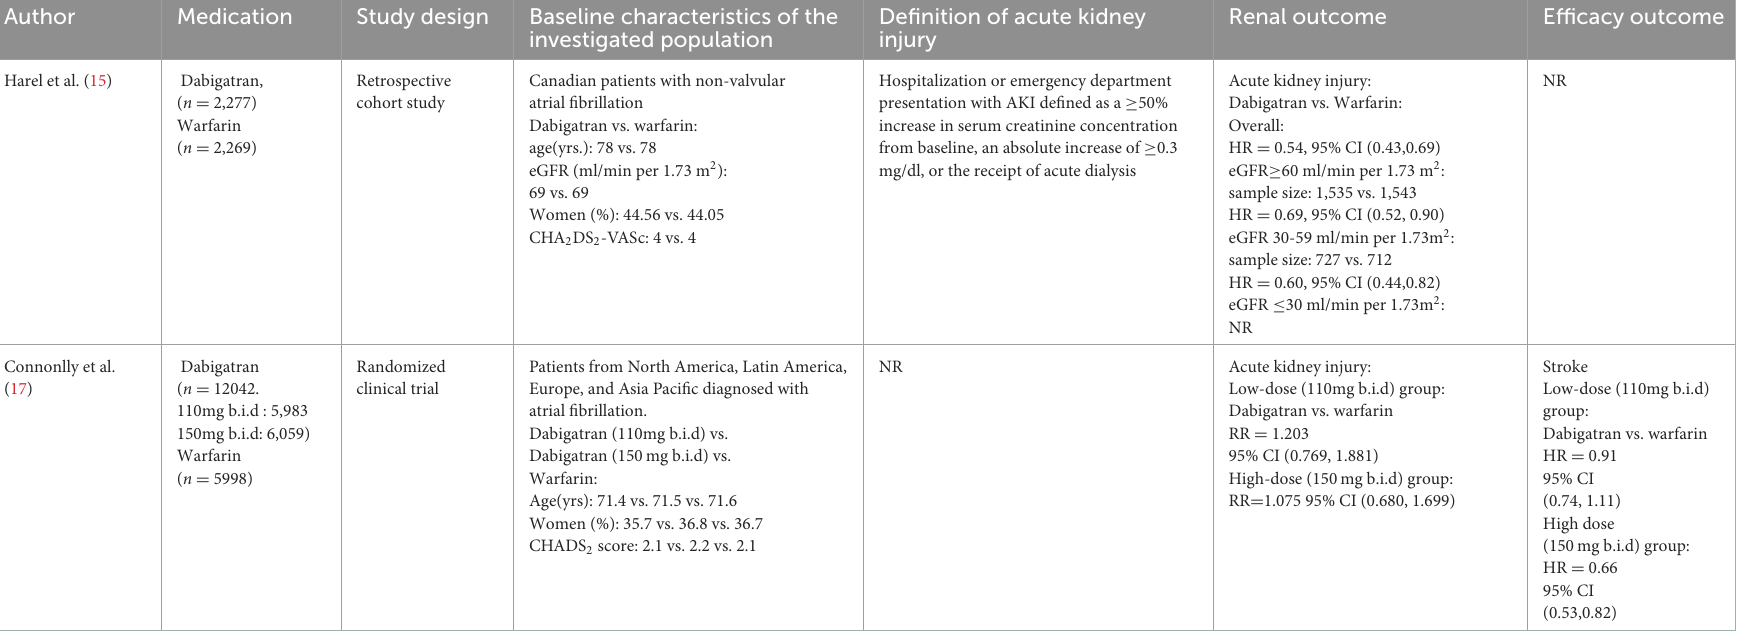
Hospitalization or emergency department presentation with AKI defined as a ≥ 50% increase in serum creatinine concentration from baseline, an absolute increase of ≥ 0.3 mg/dl, or the receipt of acute dialysis